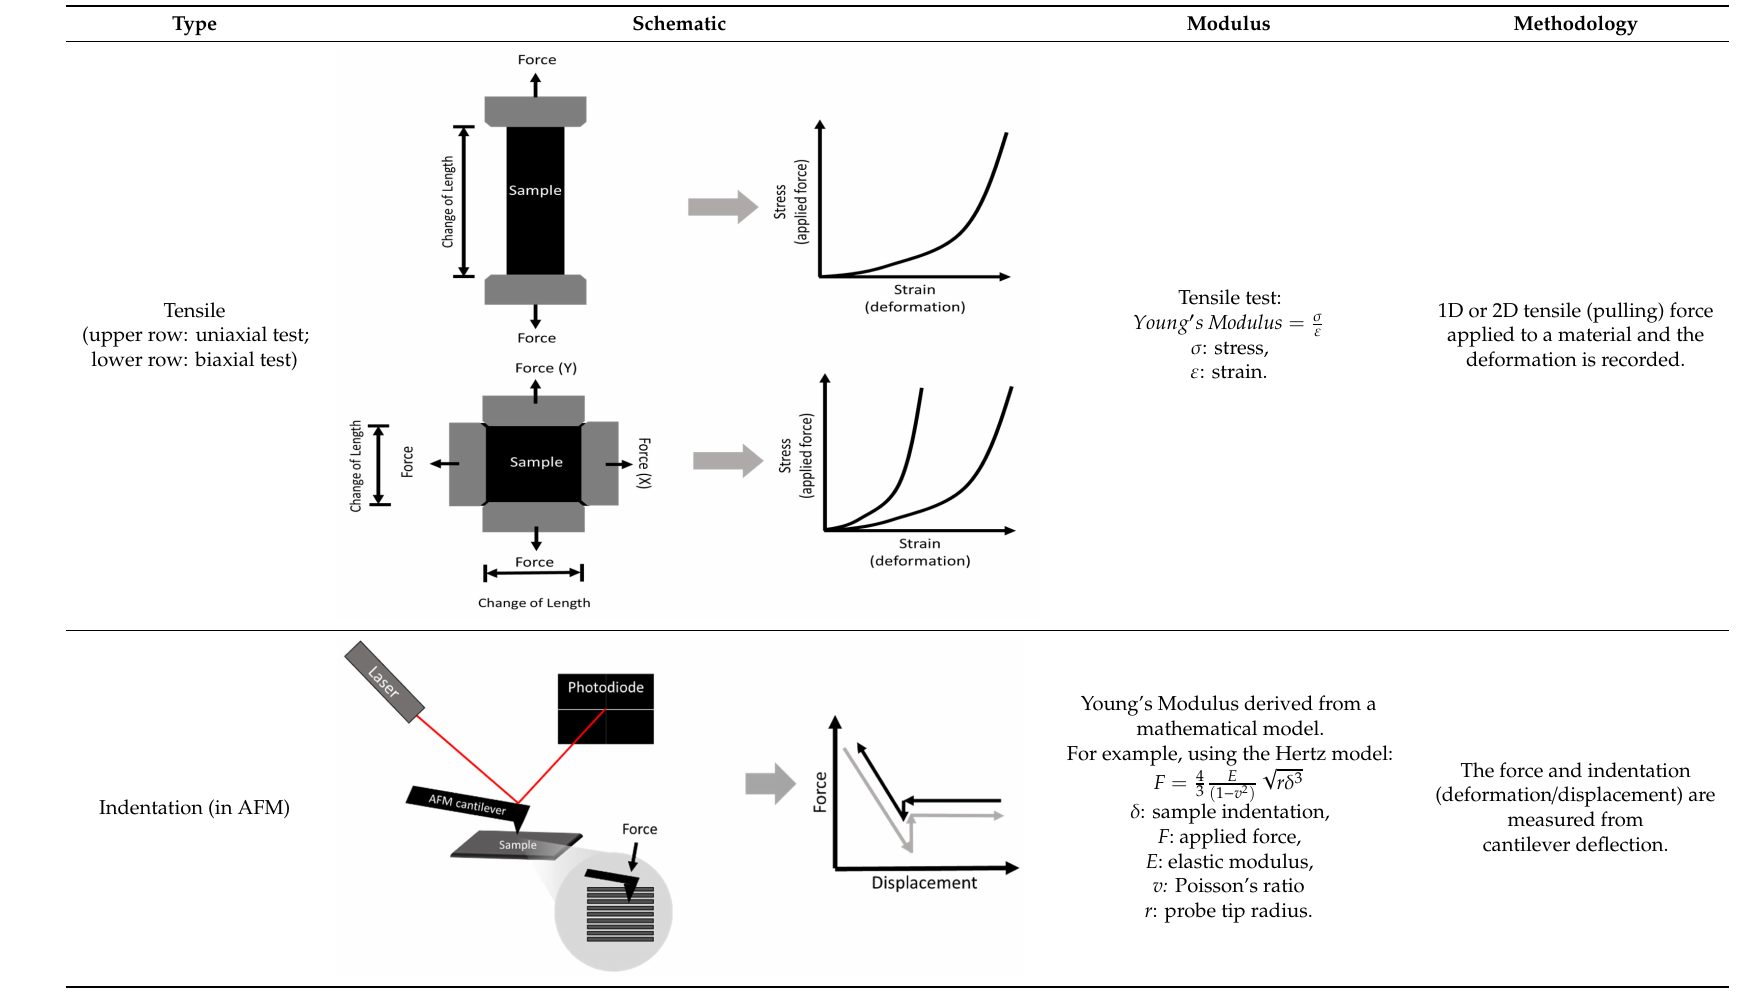
Table 2. Mechanical testing methods to derive elastic modulus of a material. Young’s modulus =